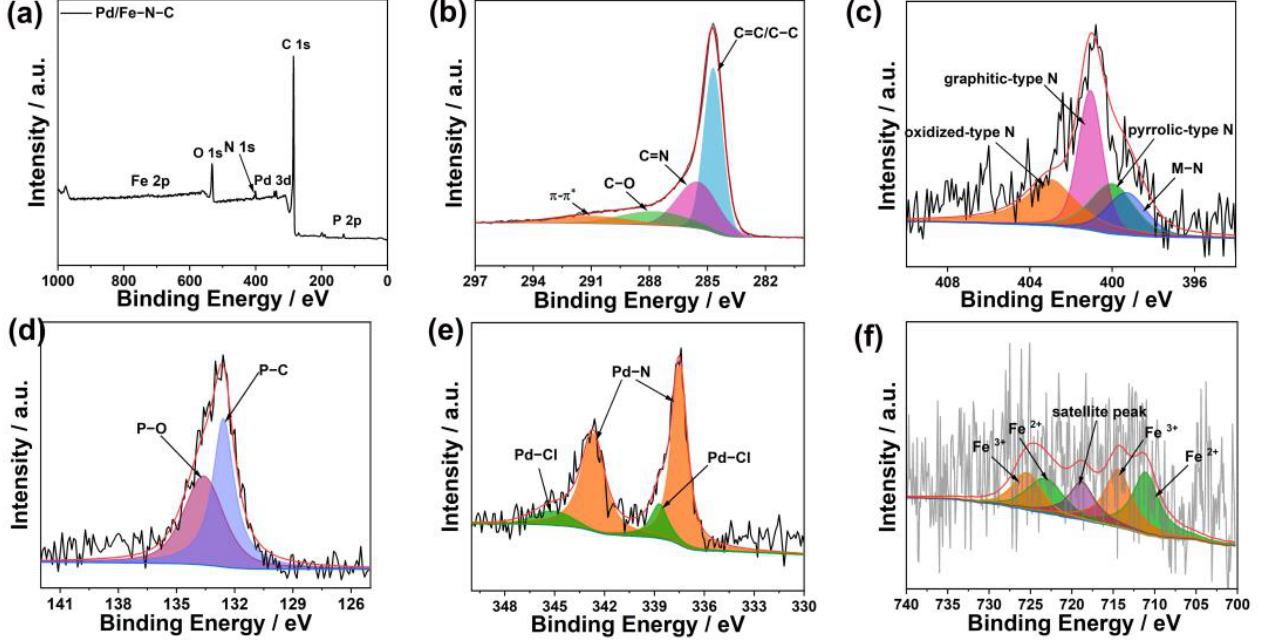
Figure 2. ( a ) XPS survey spectrum of Pd/Fe-N-C. Peak-fitting of the XPS spectra of ( b ) C 1s, ( c ) N 1s, ( d ) P 2p, ( e ) Pd 3d, and ( f ) Fe 2p.